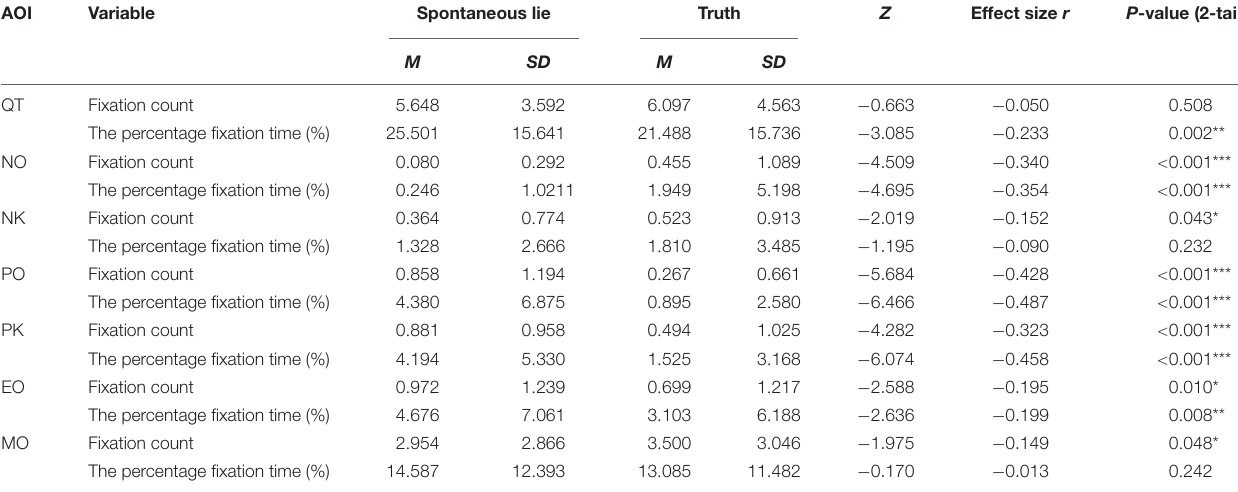
TABLE 6 | The analysis of fixation behaviors in the AOIs in Study